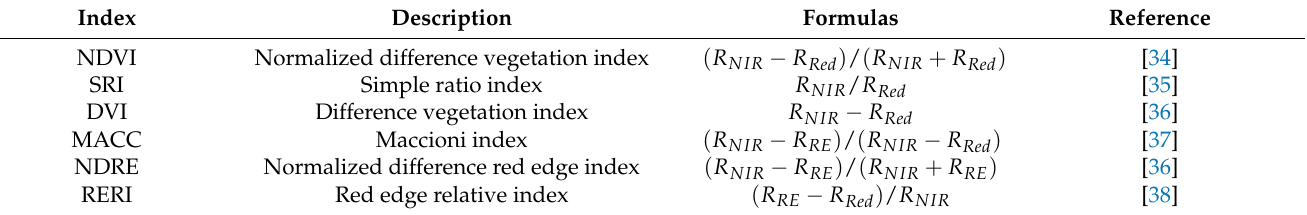
Table 1. The formulas and references for the vegetation indices used in this study.